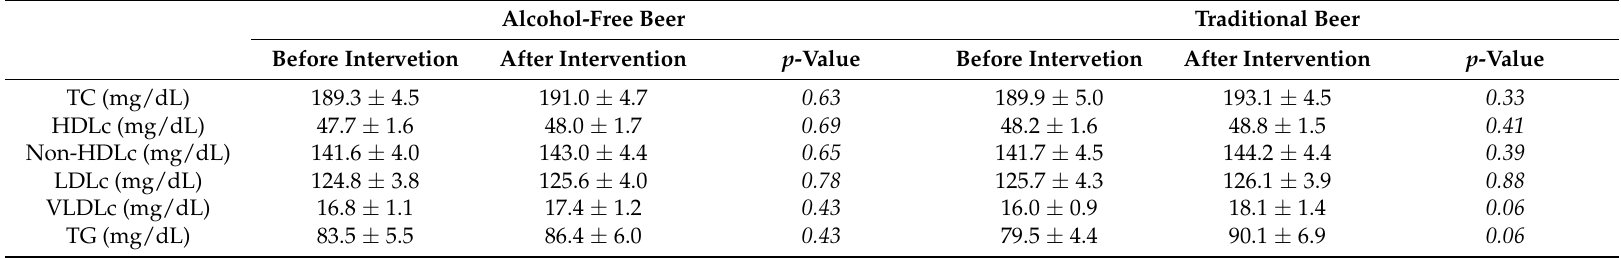
Table 4. Serum lipid levels before and after four-week dietary intervention with alcohol-free and traditional